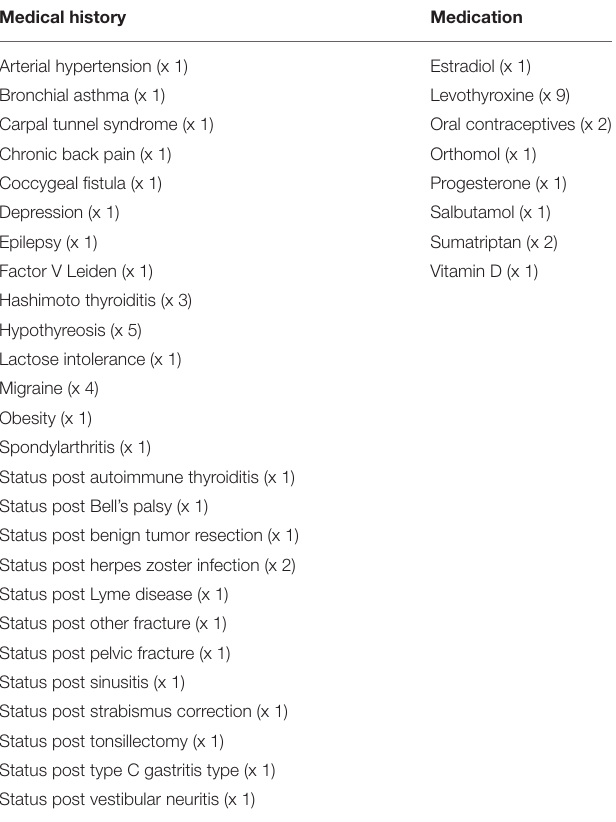
F = 2.726, df1 = 10, df2 = 29, and p = 0.017). Like in the